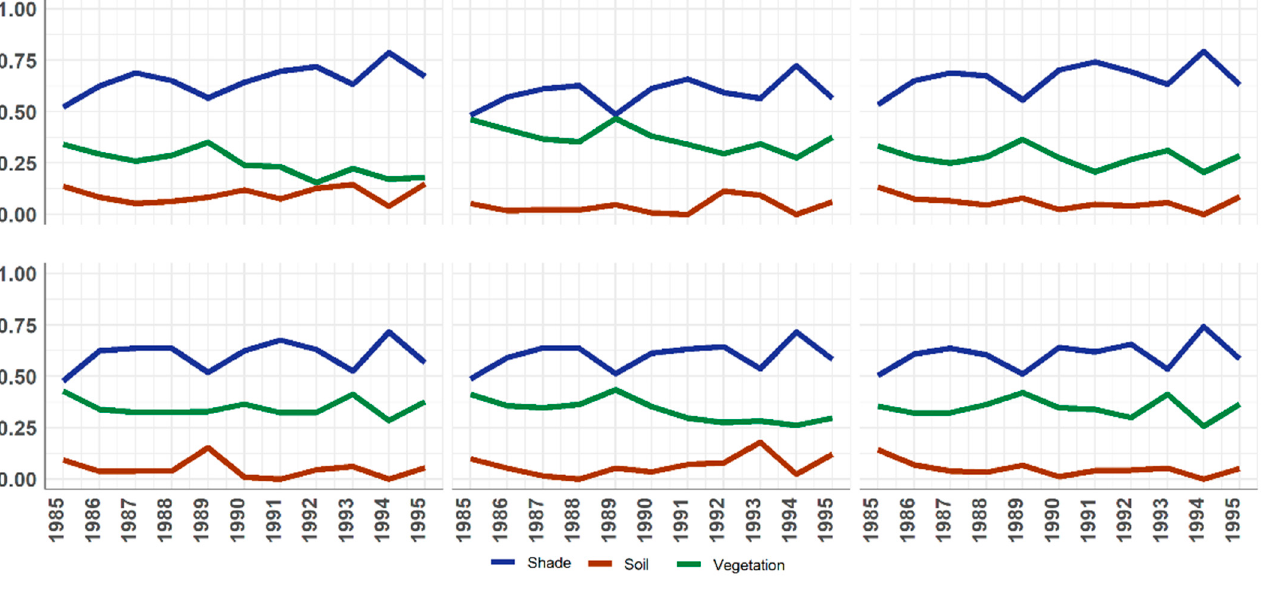
Figure 14. Phenological assessment of pine plantation in the pilot area during the 1985–1995 period based on the median fraction-image time series for six samples, as shown in Figure 2.